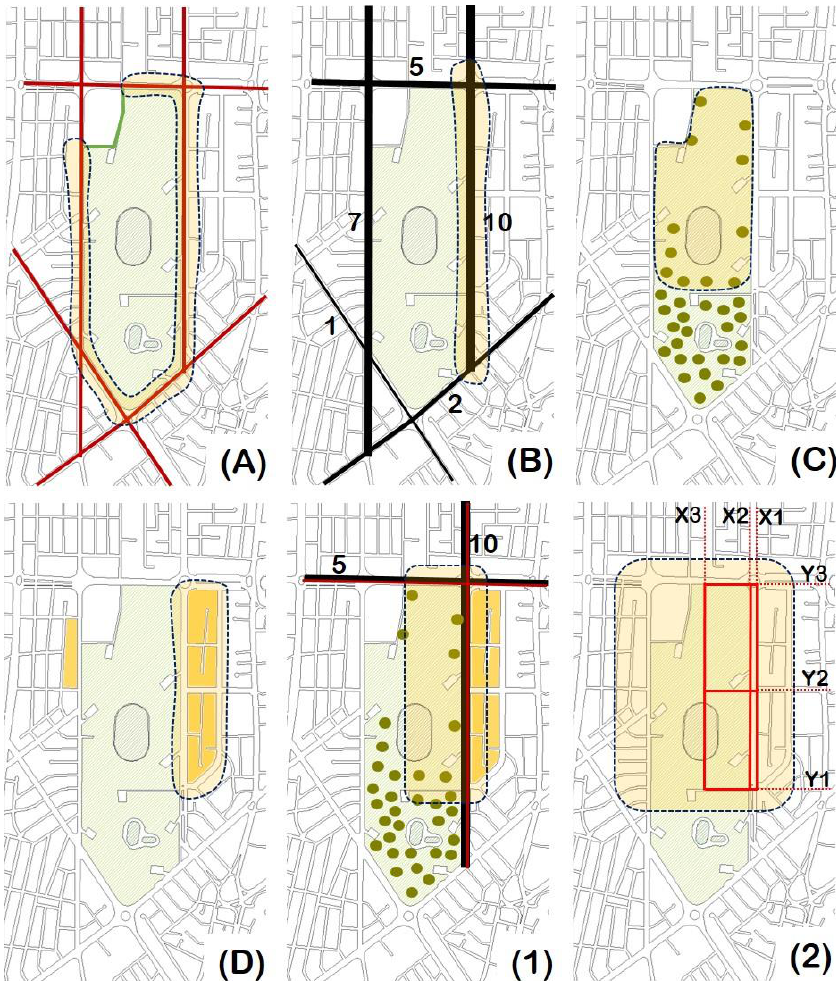
Figure 2. Selection criteria of the study area.